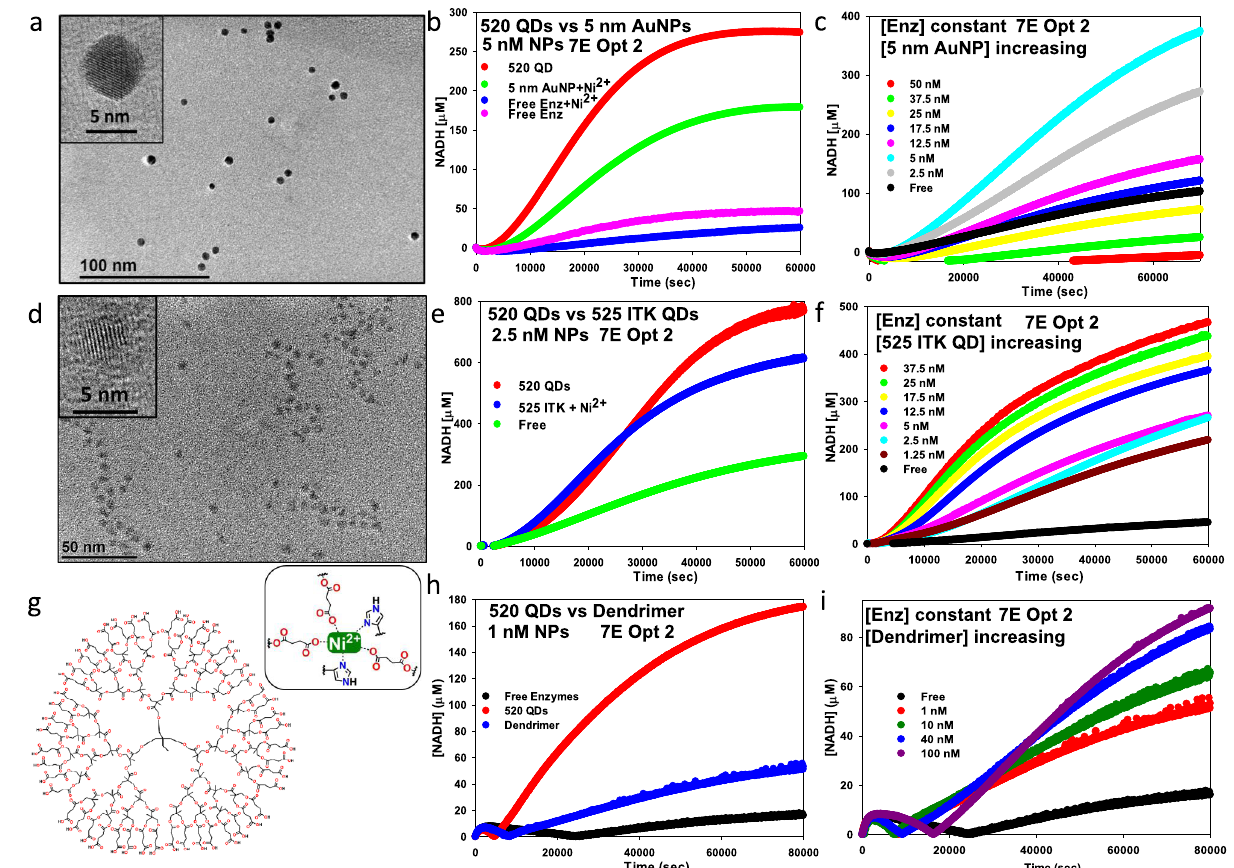
Fig. 7 | Extending channeling in other nanomaterial-enzyme clusters. a TEM micrograph of the 5nm AuNPs (dia. 5.9±0.7nm). Inset shows a high-resolution micrograph of a single AuNP where a lattice structure is visible. b Representative progress curves comparing the activity of 5nM 520 QDs and 5nM Ni 2+ -supple- mented 5nm diameter AuNPs preassembled with 7E system with the same con- centration of enzyme versus free enzyme control. c Progress curves comparing 7E activityassembledatOpt2ratiosversustheindicatedincreasingconcentrationsof Ni 2+ -supplemented 5nm diameter AuNPs preassembled with the same fi xed con- centration of enzymes. d TEM micrograph of the commercial 525nm emitting ITK carboxy QDs (dia. 5.7±0.7nm). Inset shows a high-resolution micrograph of a singleQDwithalatticestructurevisible. e Progresscurvescomparingtheactivityof 2.5nM 520 QDs and 5nM Ni 2+ -supplemented 525 ITK carboxy QDs preassembled with 7E enzymes system at the same concentration of enzyme versus free enzyme